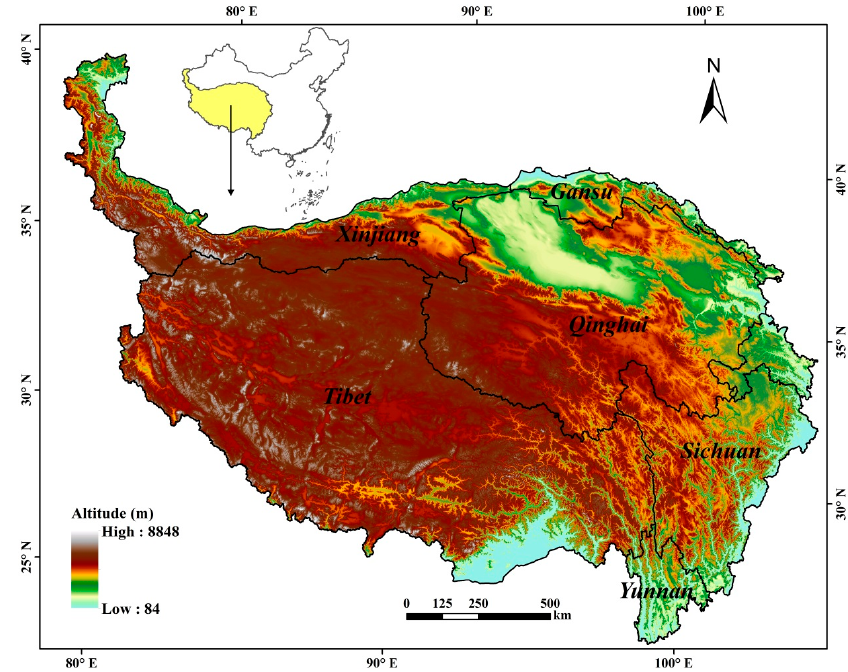
Figure 1. Location and altitude of the Tibetan Plateau.